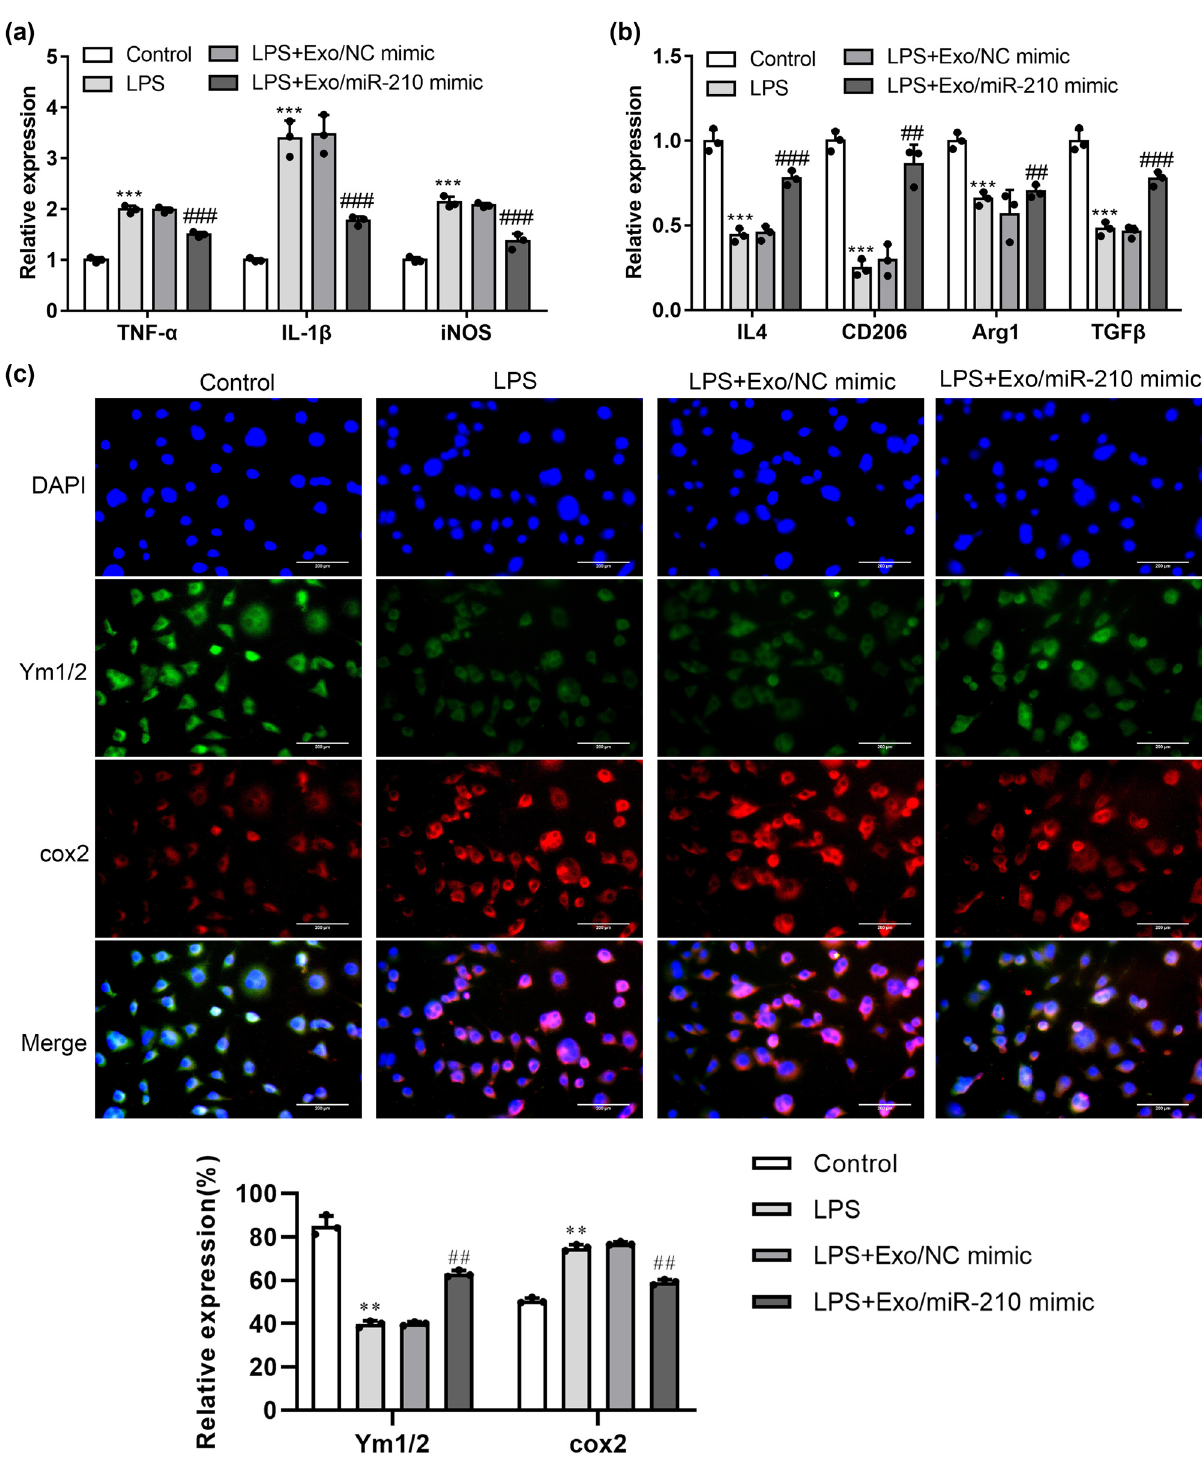
Figure 4: Exosomal miR - 210 promoted M1 to M2 phenotypic conversion of microglia. Microglia were stimulated with LPS, followed by treatment with Exo/NC mimic or Exo/miR - 210 mimic. ( a, b ) Expression of M1/M2 markers were determined by qRT - PCR ( n = 3 ) . ( c ) Representative images immunostained for M1 microglia and M2 microglia. Cox2 and Ym1/2 expressions per cell were quanti fi ed ( n = 3 ) . ** P < 0.05, *** P < 0.001 vs Control; ## P < 0.01, ### P < 0.001 vs LPS + Exo/NC